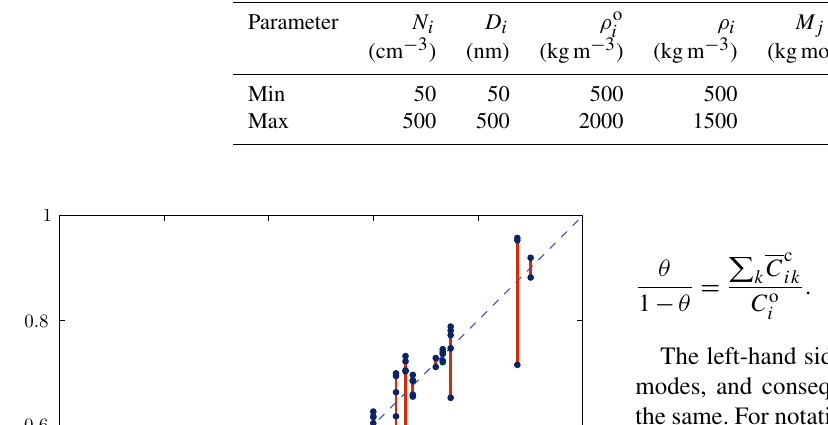
and M o are the number concentration, diameter, density and molecular i i and ν j are the van’t Hoff factors of the involatile constituents and organics. i